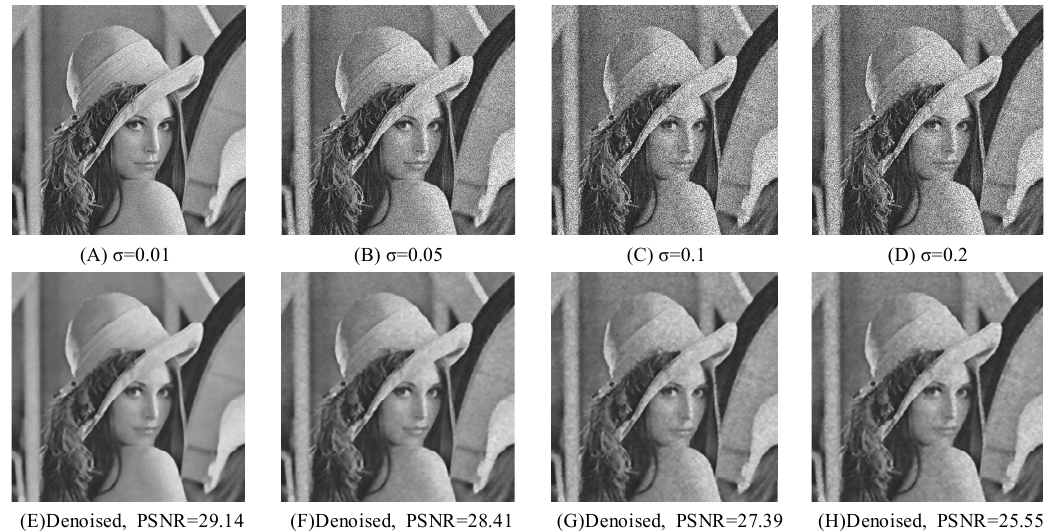
Figure 17. Denoising results of Lena with Speckle noise using IFOA ‐ DTCWT ‐ BF. (A) Lena of noise σ = 0.01; (B) Lena of noise σ = 0.05; (C) Lena of noise σ = 0.1; (D) Lena of noise σ = 0.2; (E) Denoised image of σ = 0.01; (F) Denoised image of σ = 0.05; (G) Denoised image of σ = 0.1; (H) Denoised image of σ = 0.2.